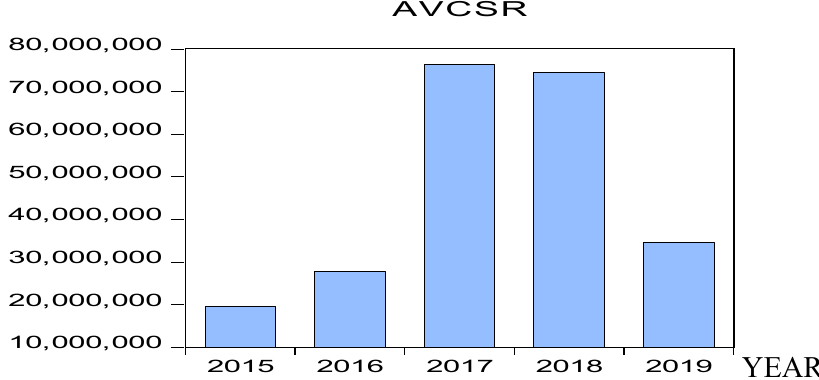
Fig. 2. Trend of corporate social responsibility investment (CSRI) (Computed by the researchers in E-views 10).